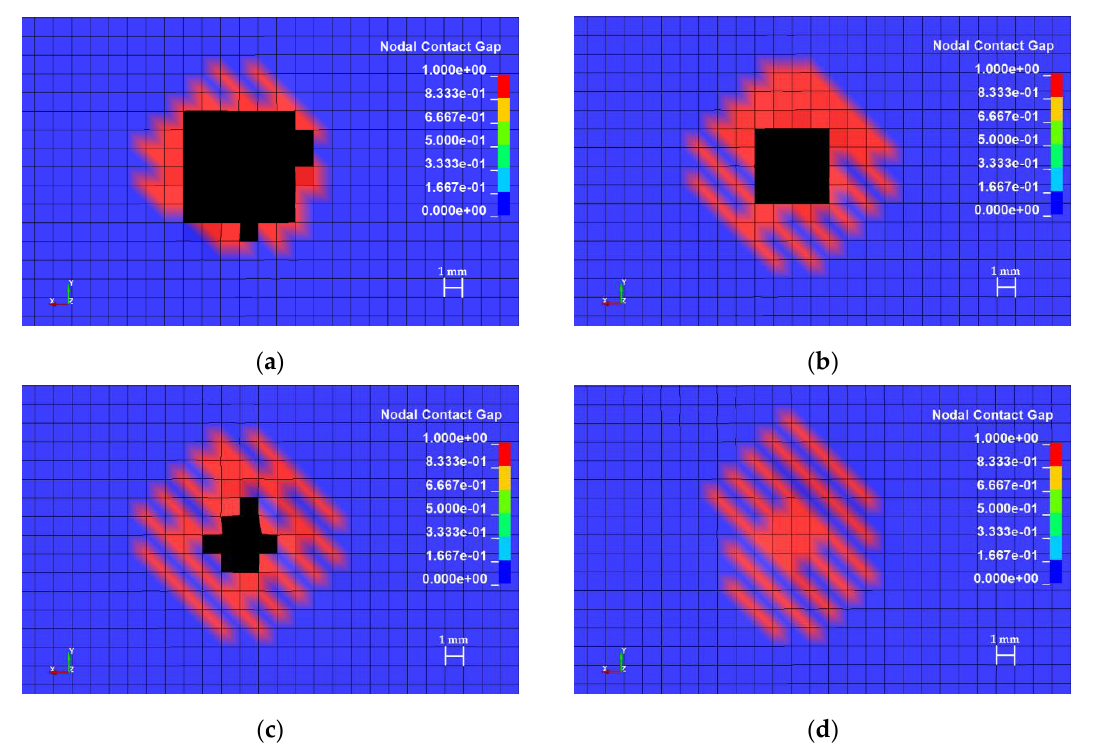
Figure 13. Colored maps of delamination areas after impact of the conical striker between layers: ( a ) 1 and 2, ( b ) 5 and 6, ( c ) 7 and 8, ( d ) 13 and 14.